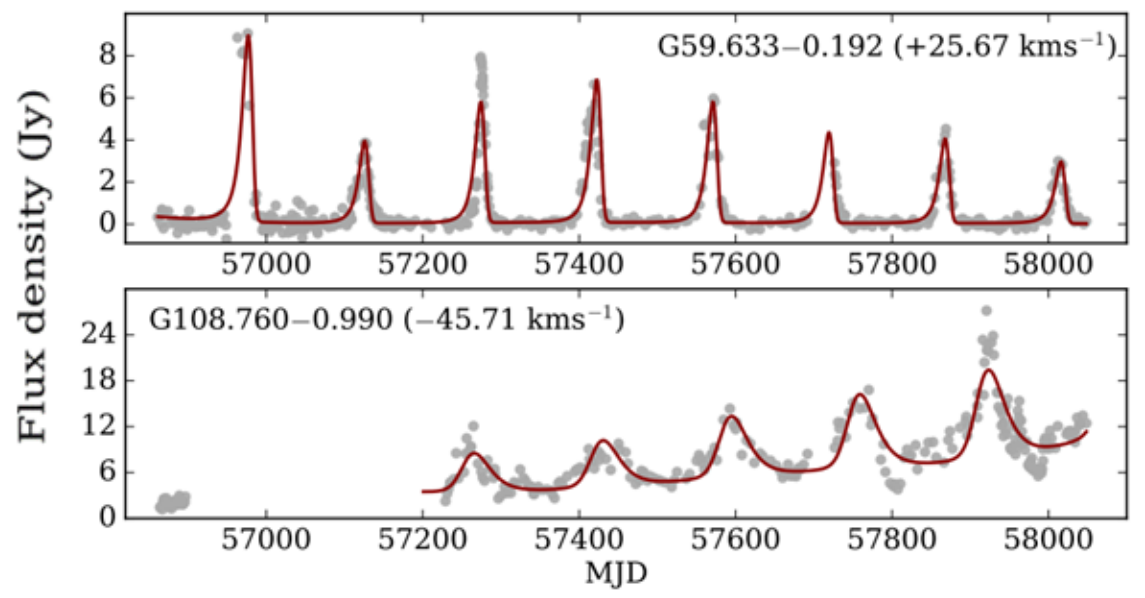
Figure 3. Time variability of two 6.668 GHz methanol masers observed with the 32 m antenna of Torún (Poland) by Olech et al. (2019). The time is indicated in Julian days, the Galactic coordinates of the sources, as well as their velocities with respect to the Local Standard of Rest are indicated inside the